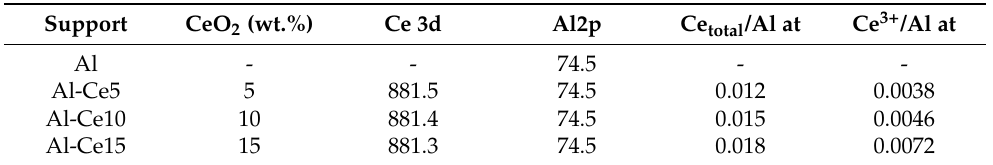
Table 1. Nominal CeO 2 content and binding energies (eV) of core levels and atomic surface ratios of pristine supports (from XPS).